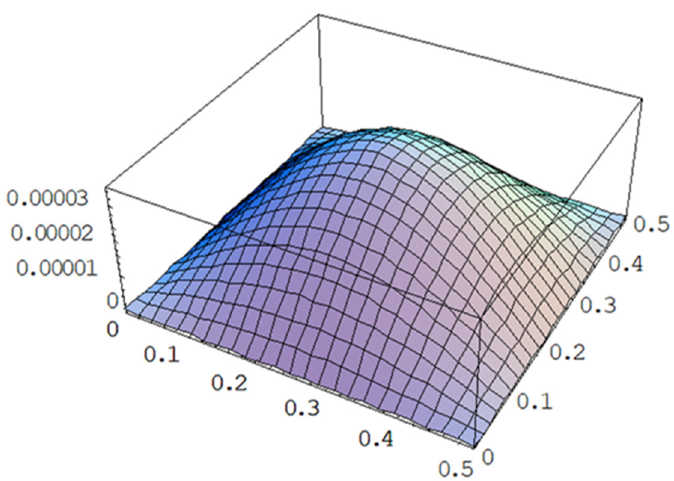
Figure 4. Vibrational amplitude (unit: mm) of a composite laminate plate excited by a PZT actuator with frequency of 143 Hz.